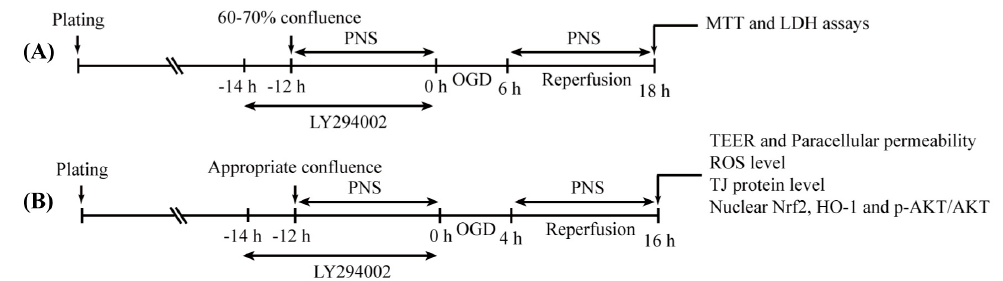
Figure 8. Experimental timeline for different experiments. ( A ) Timeline for MTT and LDH release assays. ( B ) Timeline for the measurement of TEER and paracellular permeability (peak TEER); ROS level (60–70% confluence); TJ protein level, nuclear Nrf2 activity, HO-1 level and p-Akt/Akt ratio (90%